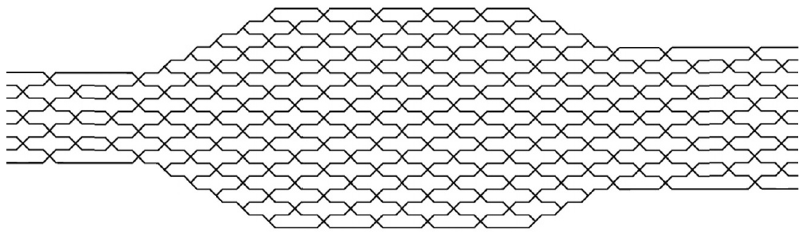
Figure 6 . The tensor network that corresponds to the Python’s Lunch geometry. The throats and bulge (where the girth is constant) are composed of unitary gates, whereas the shoulders (where the girth changes) involve projections like those shown in (cid:12)gure